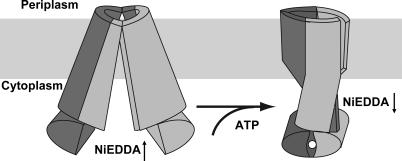
Schematic Illustration of the Conformational Changes Induced by the Formation of the High-Energy ADP/Vi IntermediateThe cartoon recapitulates the domain swapping and twisting that characterizes the structure of Sav1866 (ADP/Vi intermediate) [13]. The apo intermediate has large separations between the two NBDs (Figure 1) which leads to high accessibility to the polar reagent NiEDDA on the cytoplasmic side as reported by Dong et al. [29]. Transition to the ADP/Vi intermediate reduces accessibilities and distances on this side of the transporter.